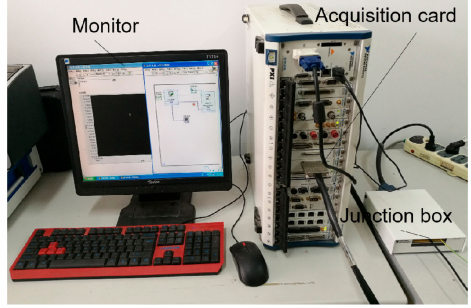
Figure 14. Data acquisition